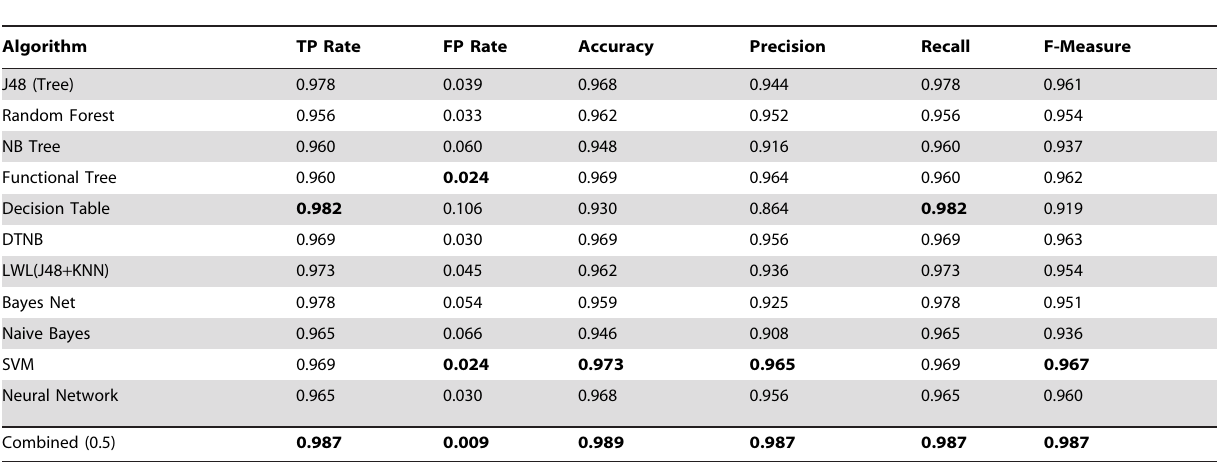
Table 3. Comparison of performance of individual and combined